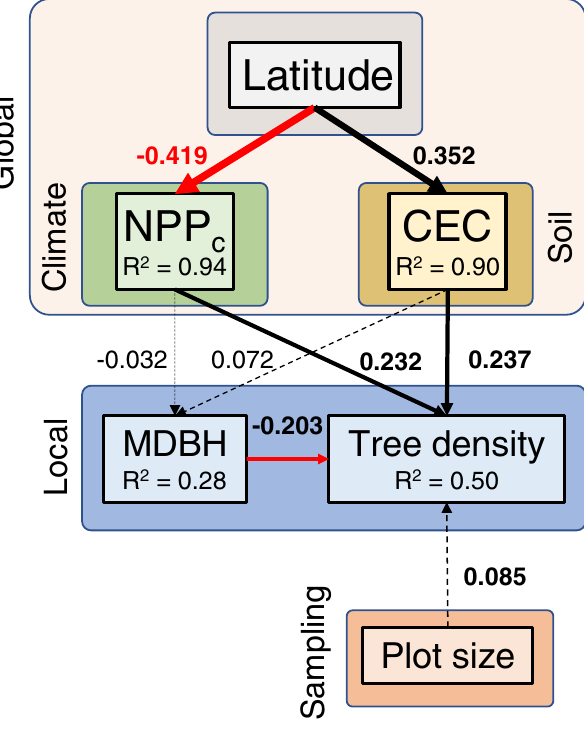
Fig. 3 Global and local determinants of tree density. Results of the structural equation model (SEM) fi tted to tree density values taking into consideration mean diameter at breast height (MDBH), Net Primary Productivity (NPPc), Cation Exchange Capacity (CEC), and plot size, an exogenous variable included as a statistical controlling factor. Both NPP and CEC depends on latitude and are considered global factors. Solid arrows represent signi fi cant effects while dotted arrows denote non-signi fi cant relationships. Red arrows represent negative effects whereas black arrows do so for positive effects. All estimates are included in the fi gure as standardized estimates.